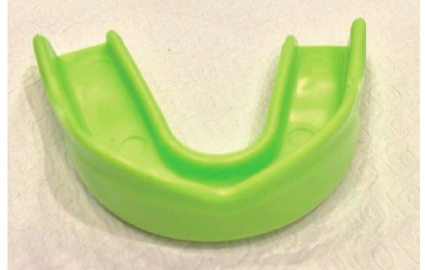
Figure 5. Stock type mouthguard [41].